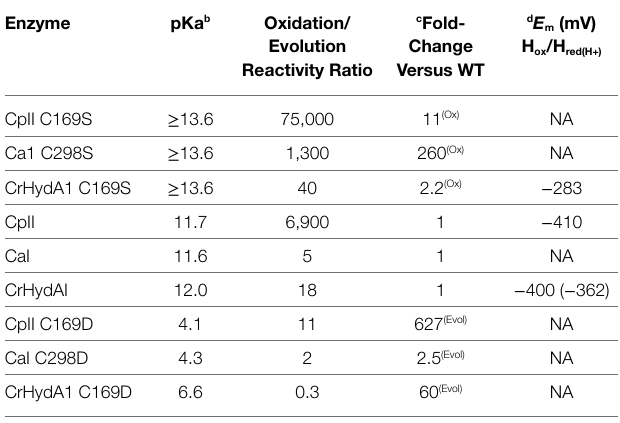
TABLE 4 | Summary of exchange site pKa on [FeFe]-hydrogenase activity a profiles.